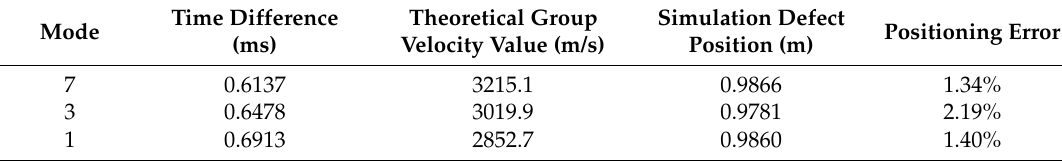
Table 7. Defect detection of each mode.